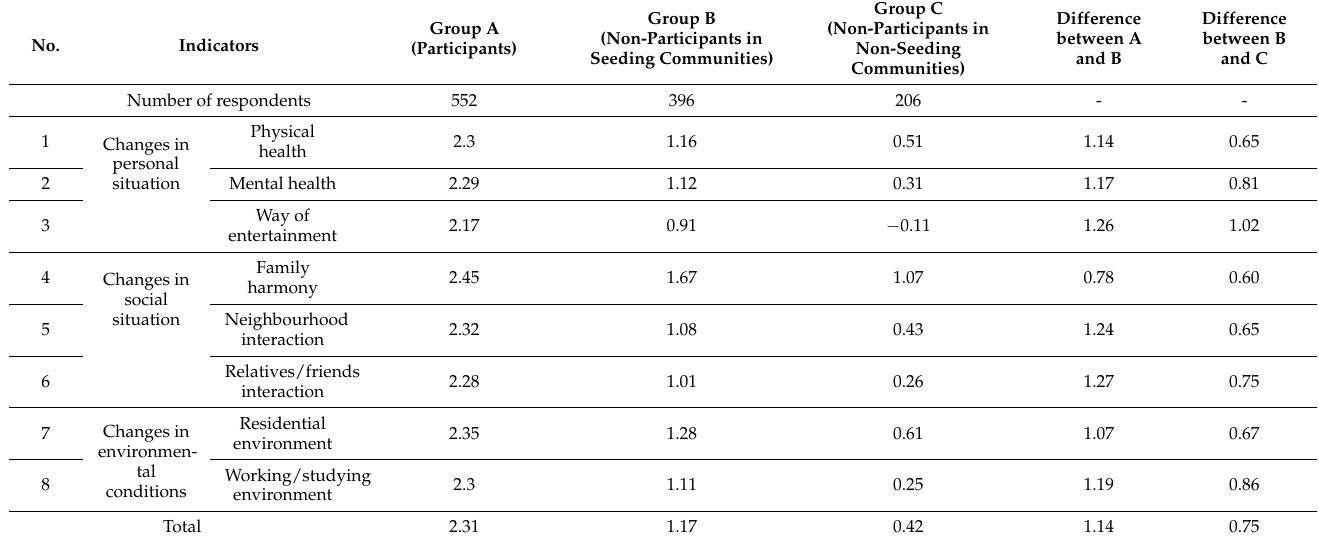
Table 2. Mean values of changes in the quality of daily life.